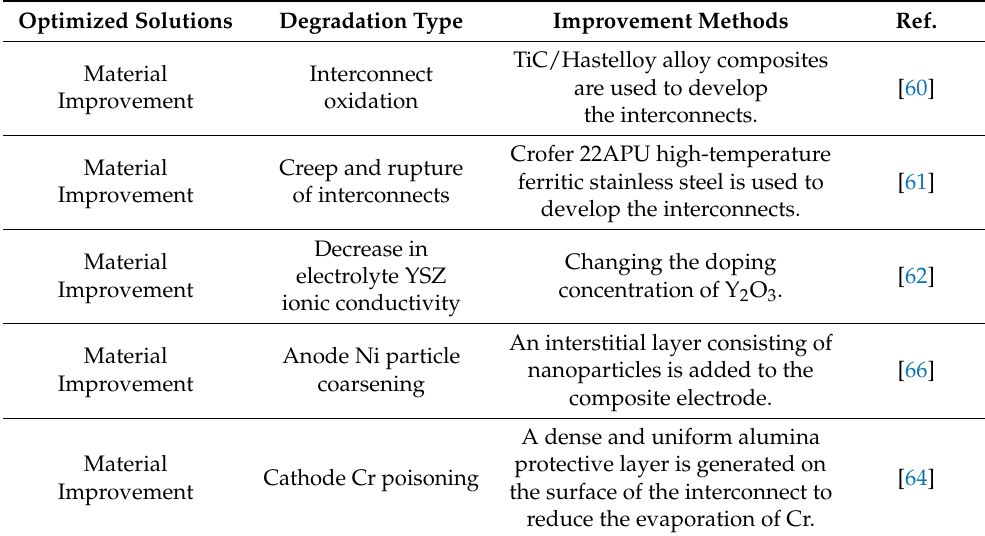
Table 4. SOFC performance optimization scheme based on material